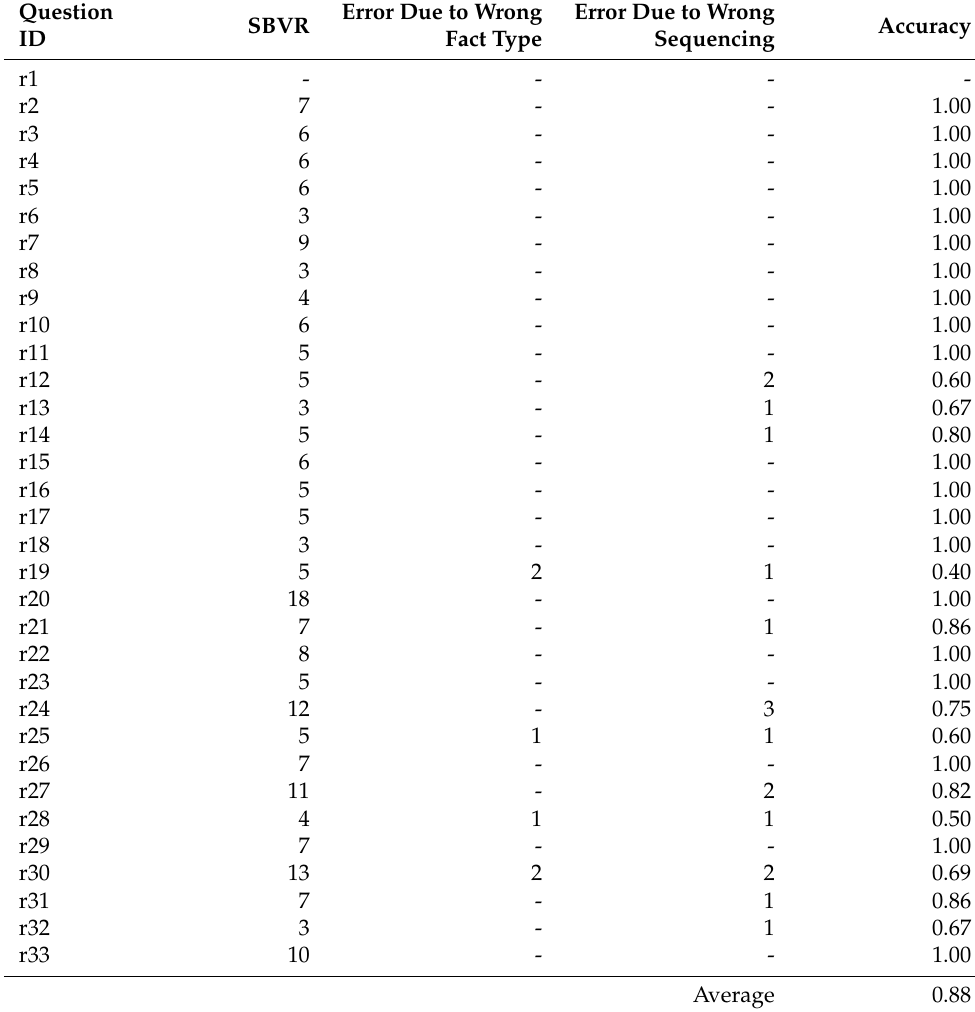
Table 6. Experimental results of generating SBVR in